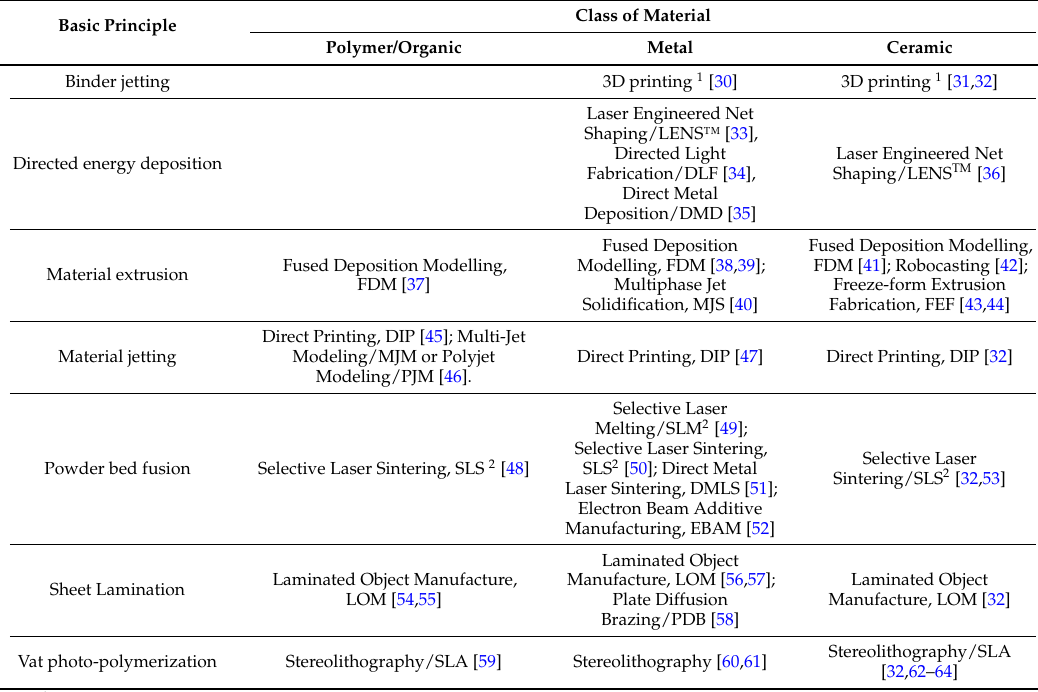
Table 1. Examples of AM techniques available today, classified by basic principle according to ASTM F2792-12a [29] and class of